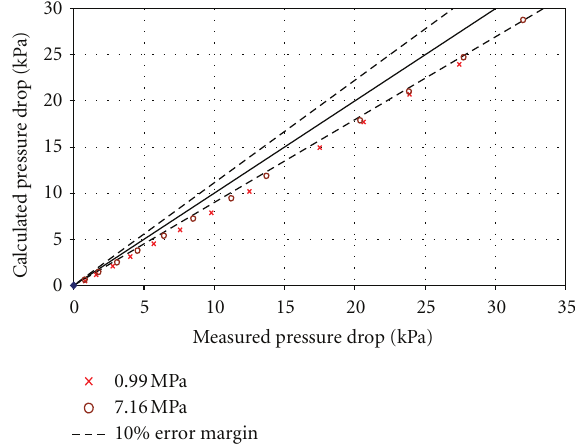
Figure 5: Comparison of predicted and measured single-phase pressure drop in BFBT tests.